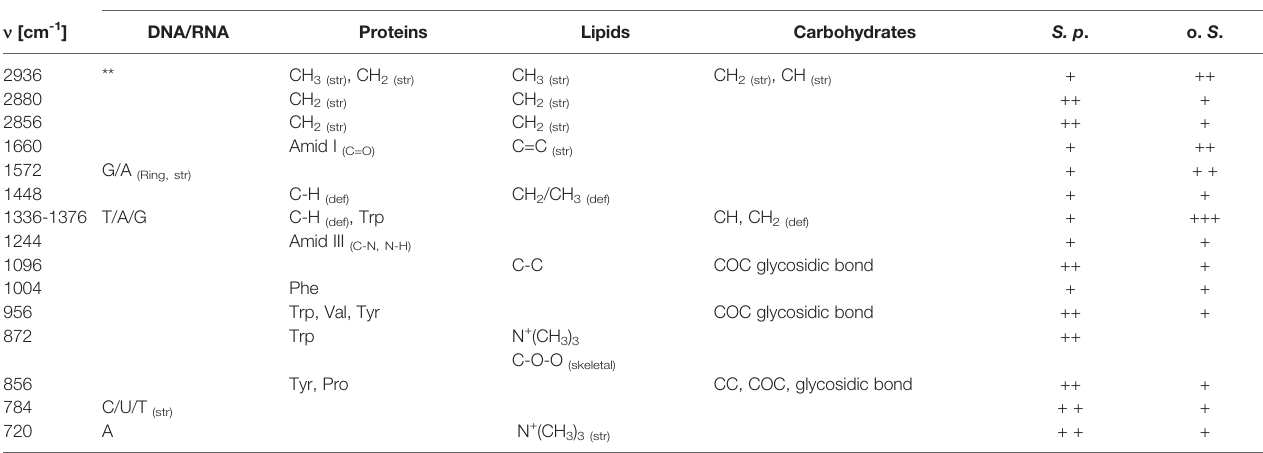
TABLE 2 | Typical Raman bands found in streptococci spectra ( Figure 1 ), assignment to functional groups and rough estimation of relative intensity of the respective Raman bands in S. pneumoniae ( S. p. ) and other streptococci (o. S .). Raman Characteristic Raman bands and assignment (Maquelin et al., 2002; Neugebauer et al., 2010; Krafft et al., 2012; Rygula et al., 2013; Czamara et al., 2015; Wiercigroch et al.,